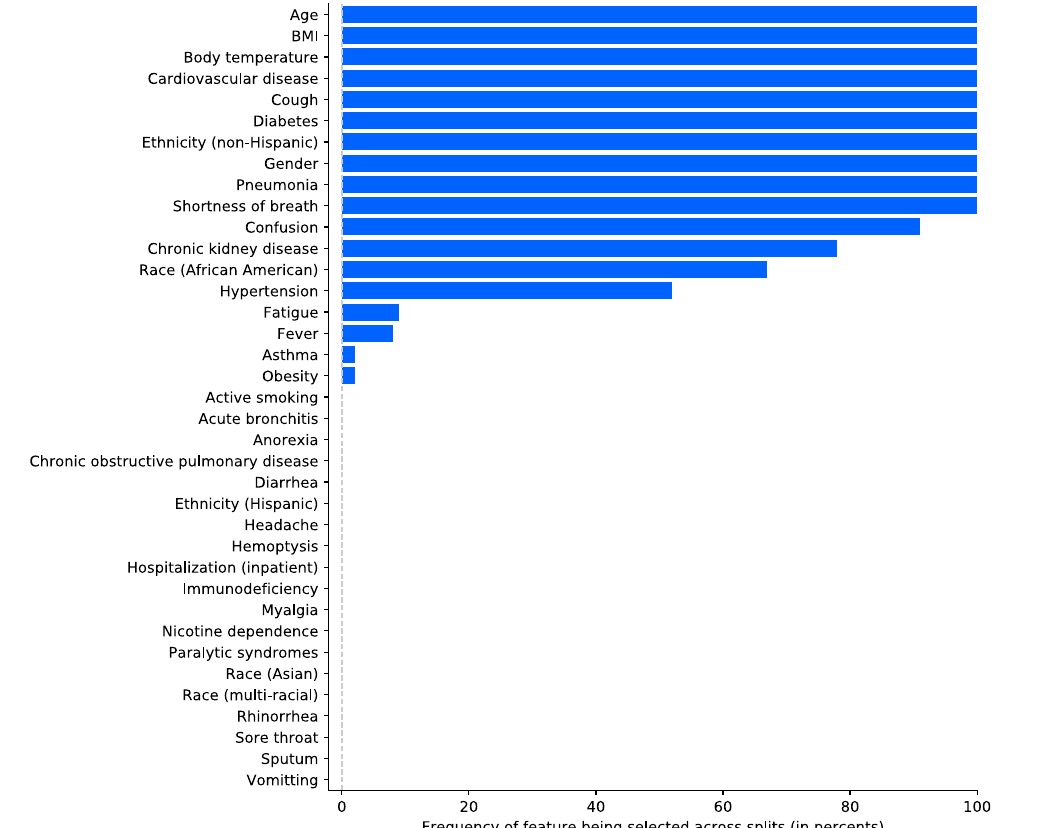
Fig. 6 Feature selection frequency across splits. Features are fi rst ordered by frequency of being selected during the feature selection process of each split and then alphabetically in case of identical